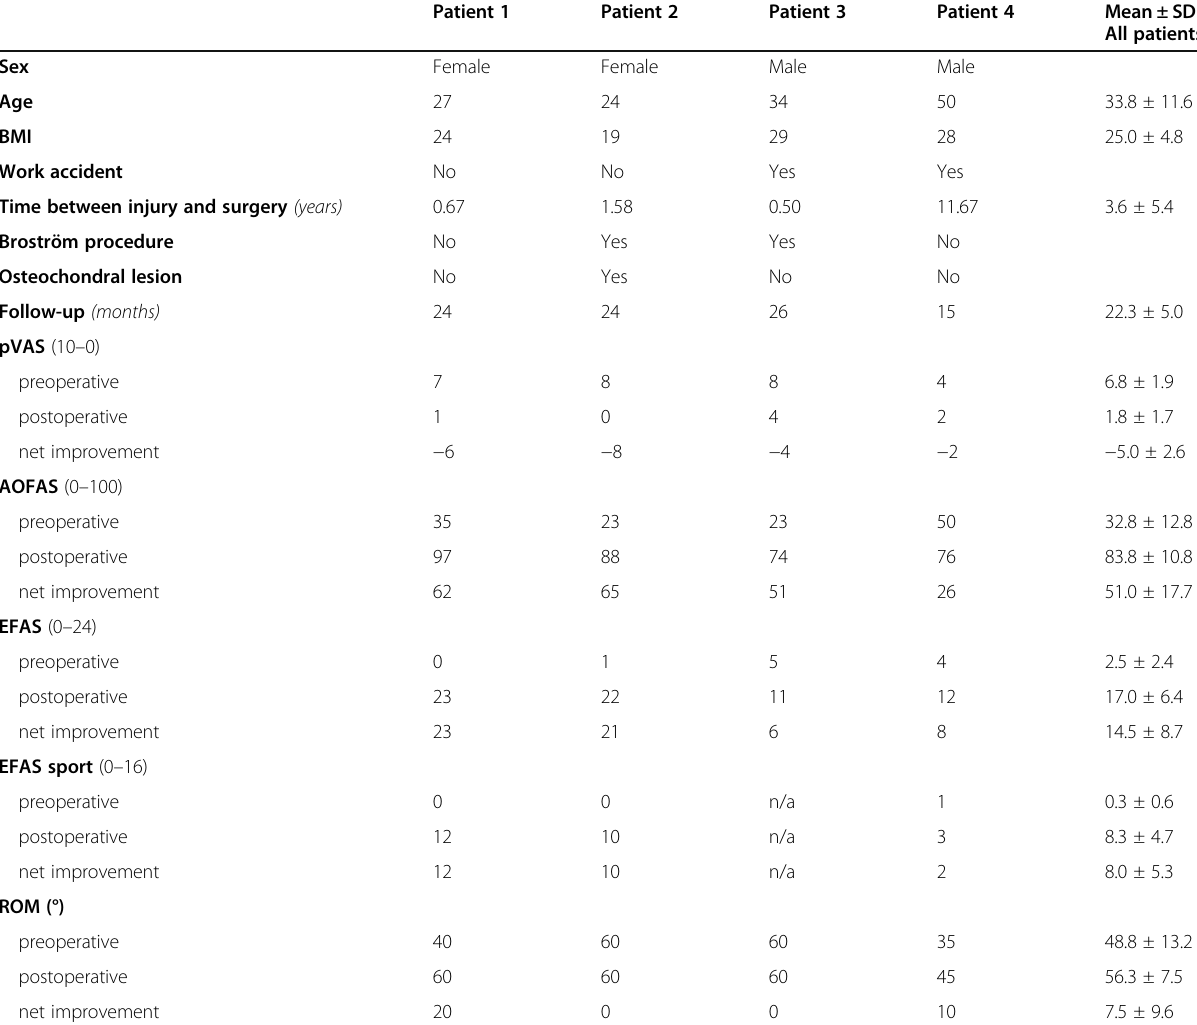
Table 1 Demographics and clinical assessment